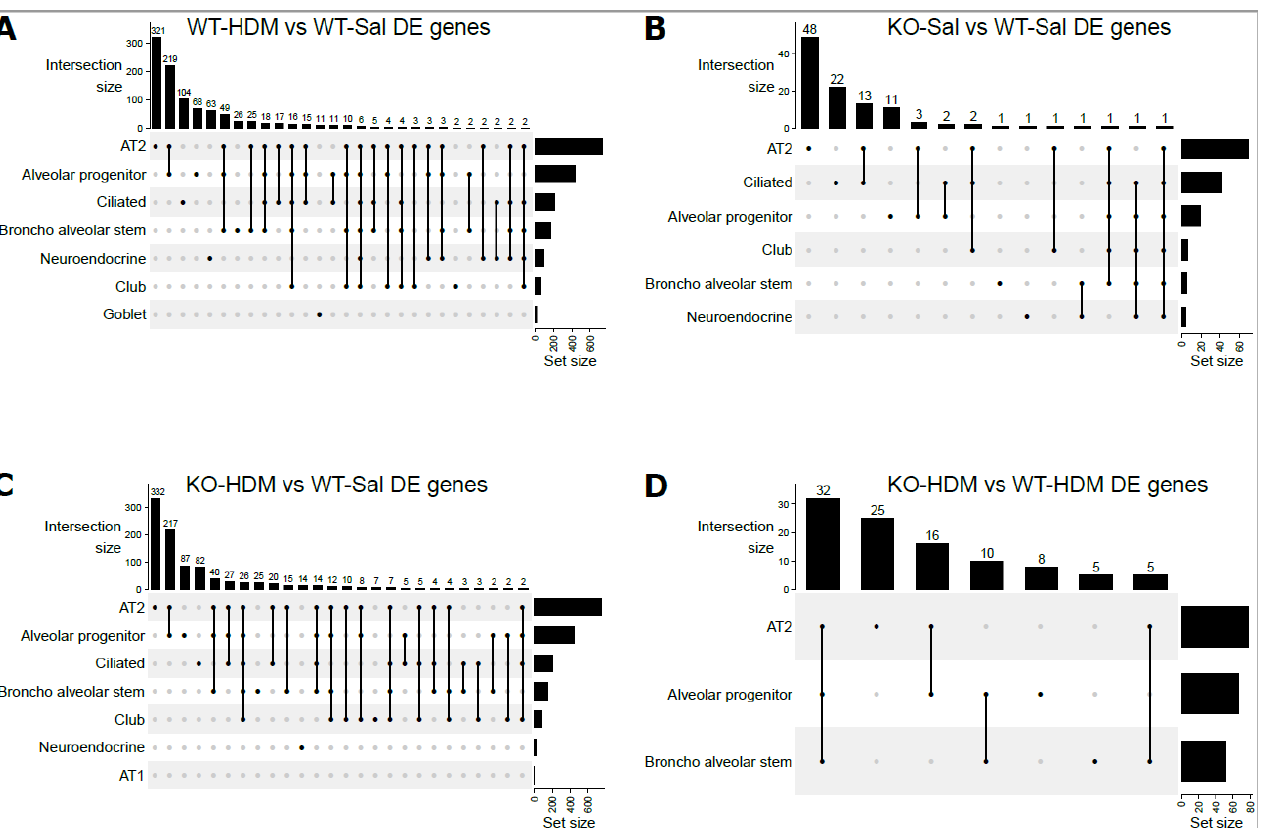
Figure 3. UpSet plots for overlapped DEGs among 8 individual cells types: ( A ) WT-Sal vs. WT-HDM; ( B ) WT-Sal vs. KO-Sal; ( C ) KO-HDM vs. WT-Sal; ( D ) KO-HDM vs. WT-HDM. Dots below vertical bars represent overlapping DEGs among different cell types. Horizontal bars represent the total number of DEGs in each cell type.